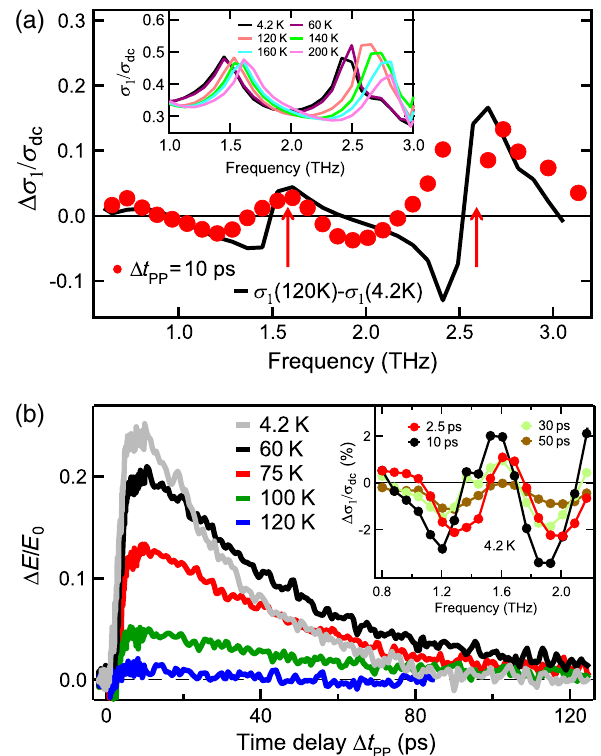
FIG. 3. The distinct spectral and temporal features of the highly nonthermal, metastable topological states. (a) Pump- ¼ induced change in conductivity ( Δ σ 1 = σ , red circles) at Δ t dc PP 10 ps and T ¼ 4 . 2 K compared with the thermal conductivity change (black circles) between 120 and 4.2 K, i.e., STI and WTI states. Inset shows the shift in the IR phonon frequencies in the static conductivity along the a axis as a function of the temper- ature. (b) Differential THz transmission profiles ( Δ E=E 0 ) for various temperatures show that the relaxation of the metastable ∼ 60 K. Inset: THz response state is the longest near T Lifshitz Δ σ σ as a function of the frequency for time delays 1 = dc Δ t ¼ 2 . 5 , 10, 30, and 50 ps at E ¼ 736 kV = cm at 4.2 PP THz